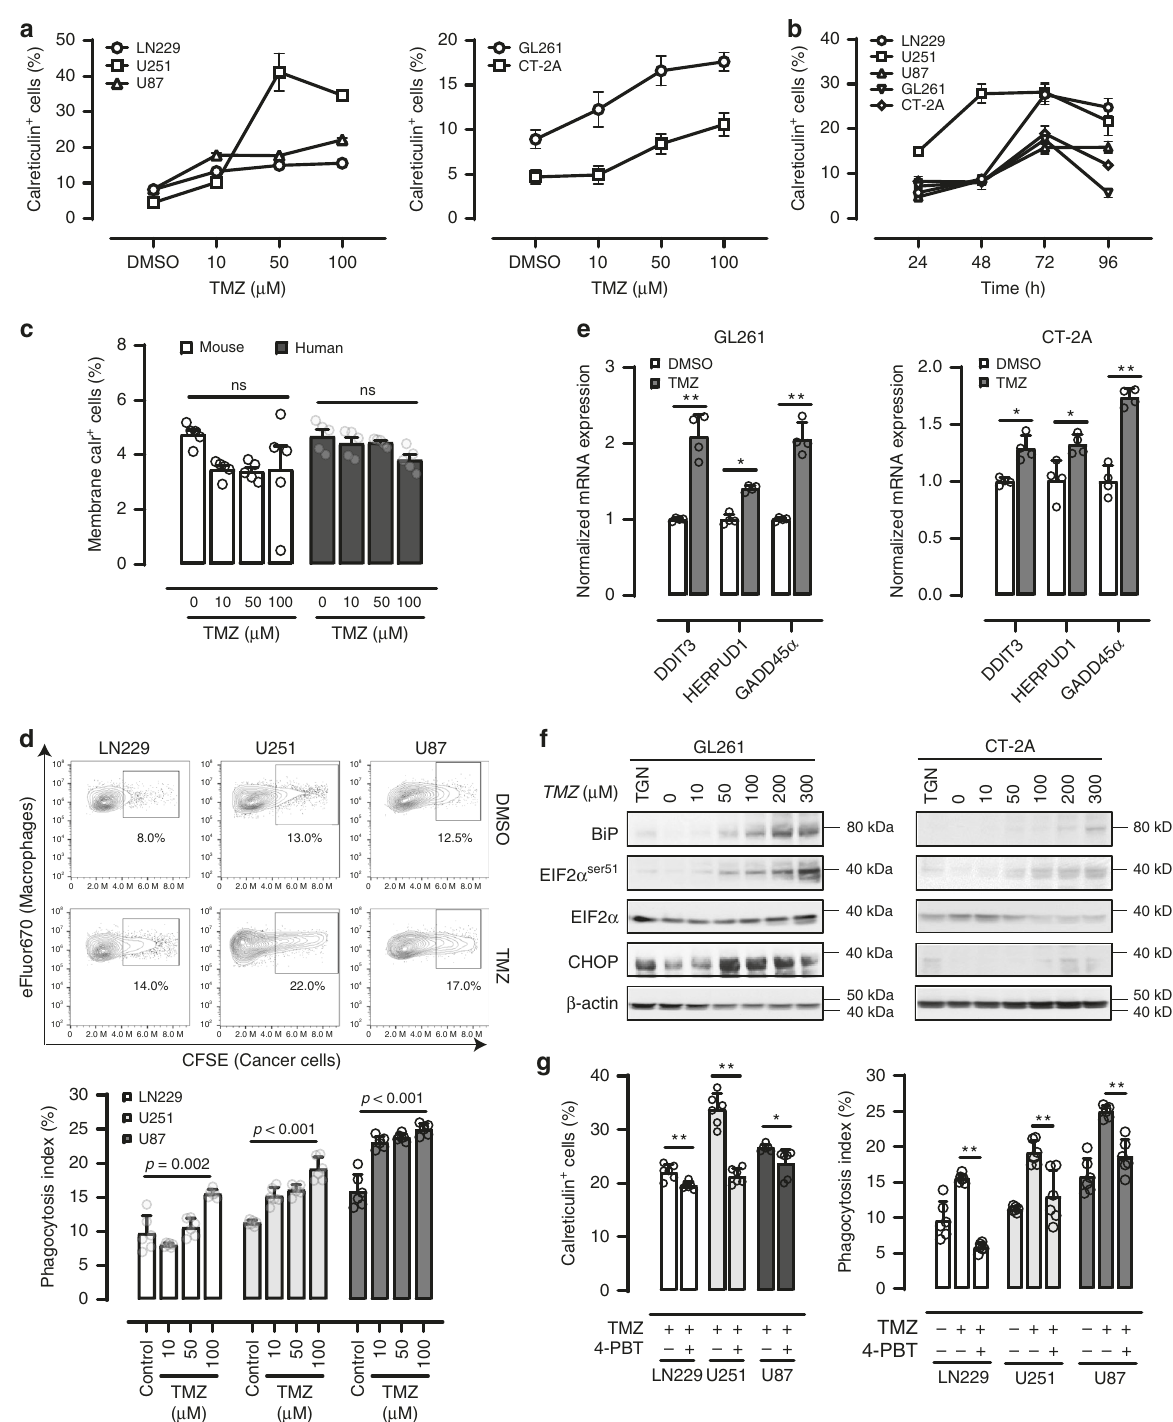
Fig. 2 Temozolomide (TMZ) promotes GBM cell phagocytosis by bone marrow (BM)-derived phagocytes. a TMZ induces translocation of the ER chaperone calreticulin to the plasma membrane in both human and murine GBM cells in a concentration dependent manner. n = 6. b The membrane translocation of calreticulin induced by TMZ was transient, with peak occurring at 72-h post treatment. n = 6. c TMZ treatments did not result in signi fi cant membrane translocation of calreticulin in human or mouse normal bone marrow cells. d TMZ treatment promotes GBM cell phagocytosis by BM-derived phagocytes. n = 6. Unpaired Student ’ s t test. e TMZ treatment (50 μ M) upregulated the mRNA expression of ER response-associated targets DDIT3, HERPUD1, and GADD45 α in mouse GBM cells. n = 4. ** < 0.01, * < 0.05 (Unpaired Student ’ s t test). f Western blot showing TMZ treatment increased the expression levels of ER stress response-speci fi c protein BiP, phospho-EIF2 α , and CHOP in mouse GBM cells. TGN thapsigargin. g Addition of the ER stress inhibitor 4-PBT diminished the pro-phagocytosis and calreticulin translocation effect of TMZ. n = 6, * < 0.01 (Unpaired Student ’ s t test). Error bar = mean ± standard